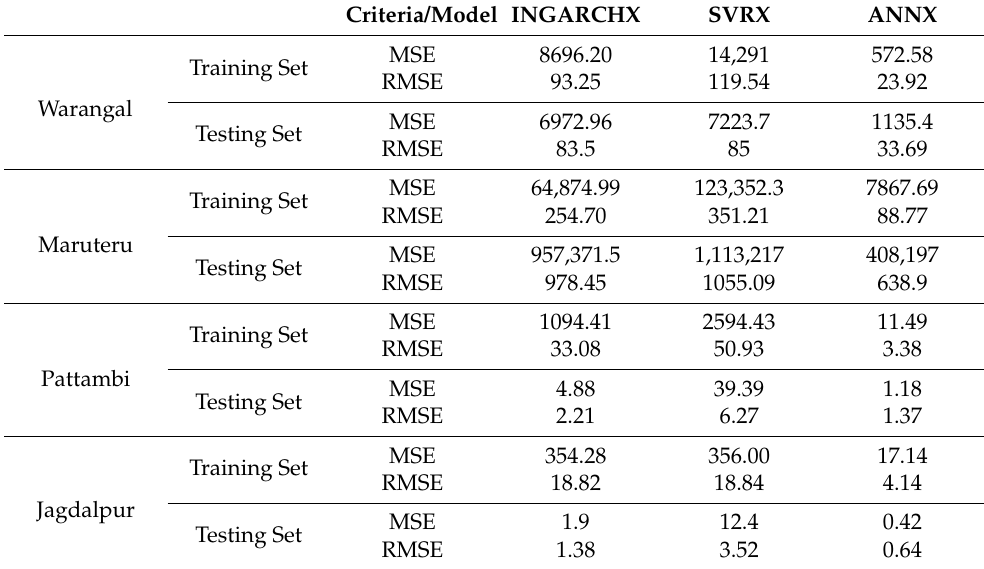
Table 6. Comparison criteria for different models for gall midge populations in training and testing data